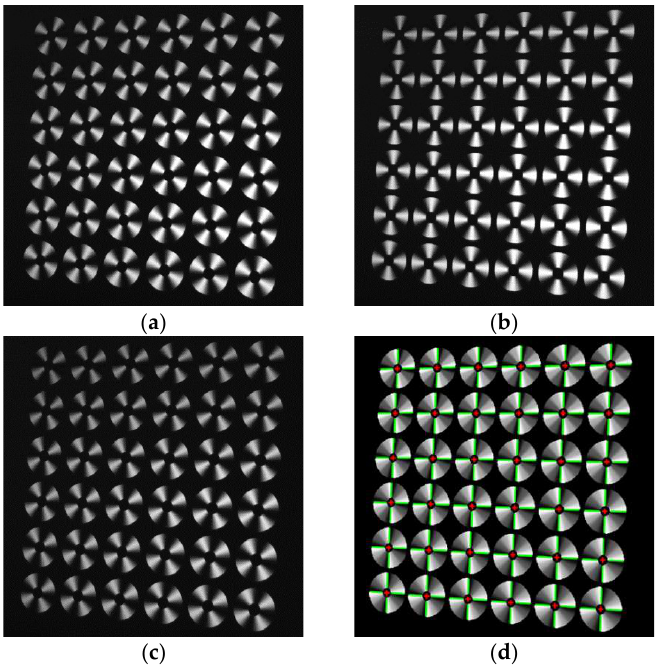
Figure 5. Feature detection example. ( a – c ) three PWG arrays; and, ( d ) the wrapped phase with detected feature points (red cross ‘+’).